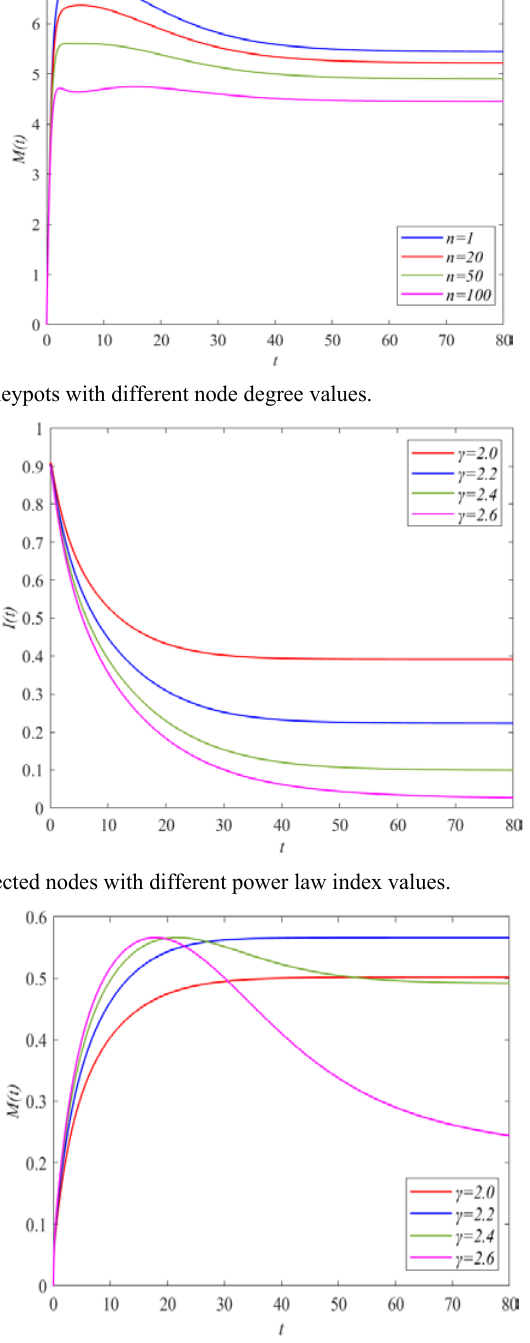
Fig. 7. Evolution of honeypots with different power law index